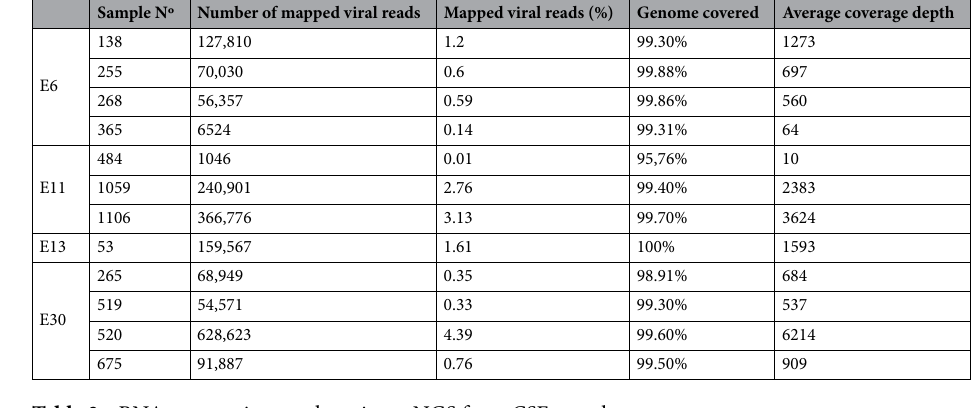
Table 2. RNA-sequencing results using mNGS from CSF